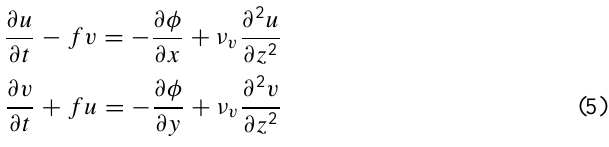
FIG. 4: Hodographs of the horizontal velocity vectors in the middle of the rectangular basin in 0, 5, 10, 20 and 60 m depth (a). In order to see the spiral at 20 m depth more clearly the 20 m hodograph is shown separately in (b). The motion starts from a state at rest. The small circles mark time intervals of 1/4 inertial period